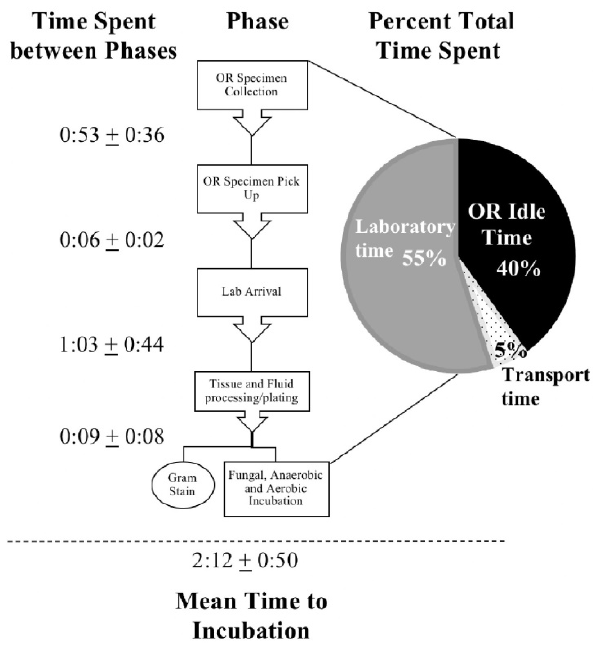
Figure 1. Percent Breakdown of Time by Phase Before Incubation